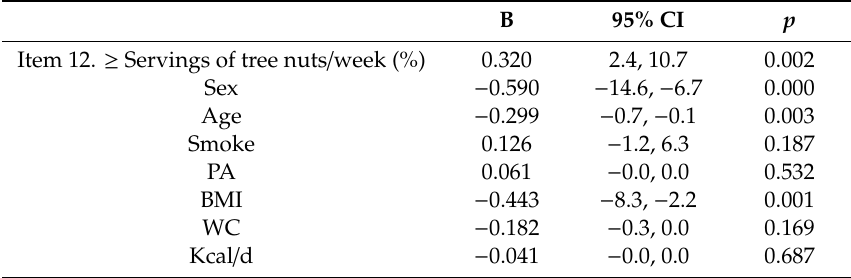
Table 5. Standardized beta coe ffi cients from linear multiple regressions with cardiorespiratory fitness as a dependent